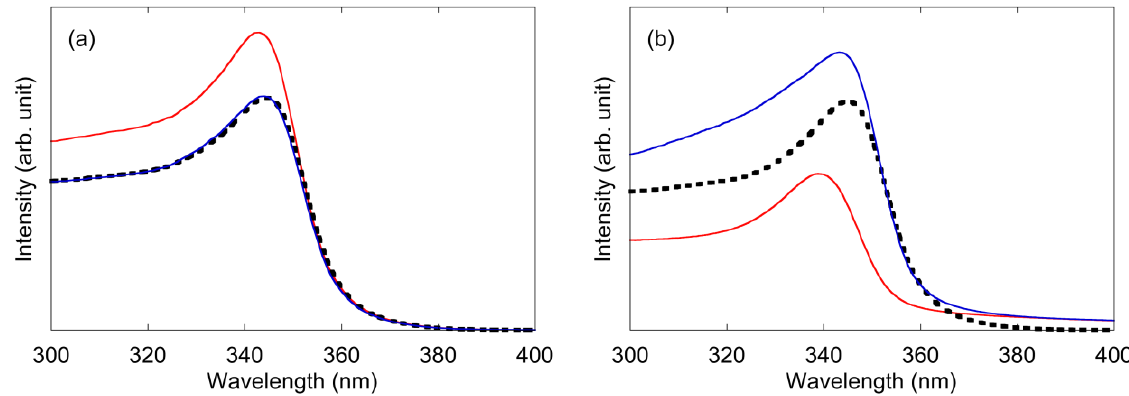
Figure 5. PLE spectra of ZnO nanoparticle solution with an emission wavelength of 500 nm: ( a ) PEG was added to the solution; ( b ) PVP was added to the solution. Black dotted line: polymer was not added to the solution. Red solid line: polymer was added before the synthesis of ZnO nanoparticles. Blue solid line: polymer was added after the synthesis of ZnO